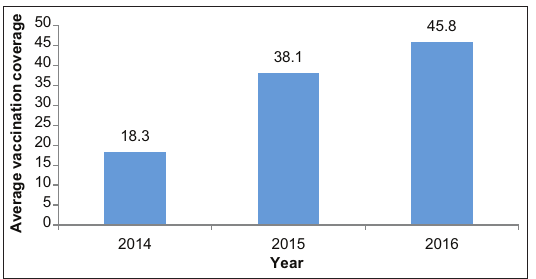
Figure 1: Trends in measles vaccination coverage rates from